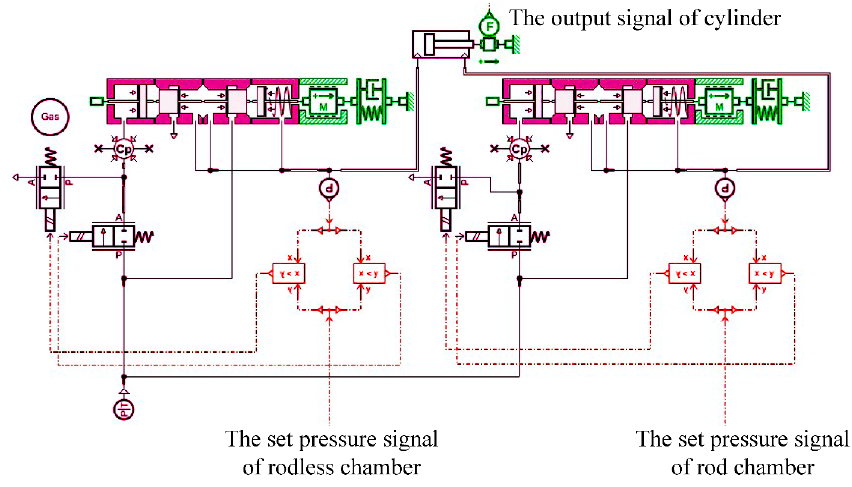
Figure 9. AMESim simulation model of clamp’s pneumatic servo control system. Table 2. Simulation parameters of ITV3050 electro-proportional valve.